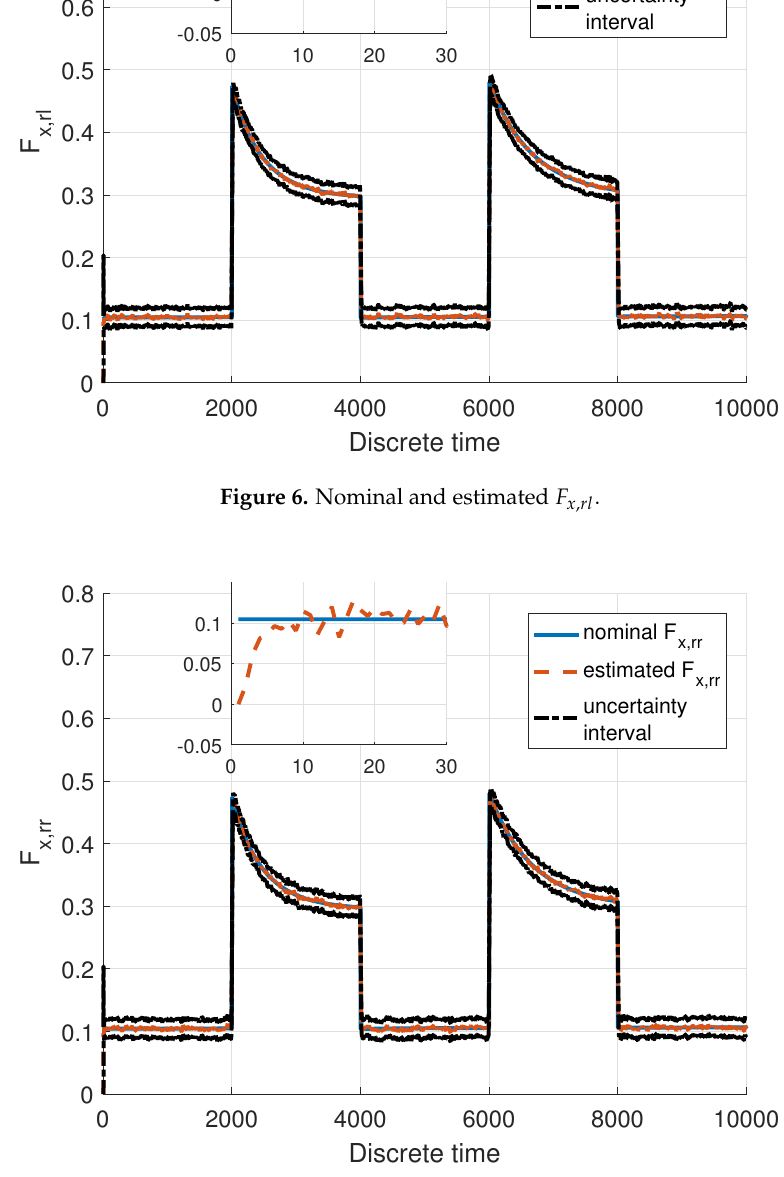
Figure 7. Nominal and estimated F x , rr